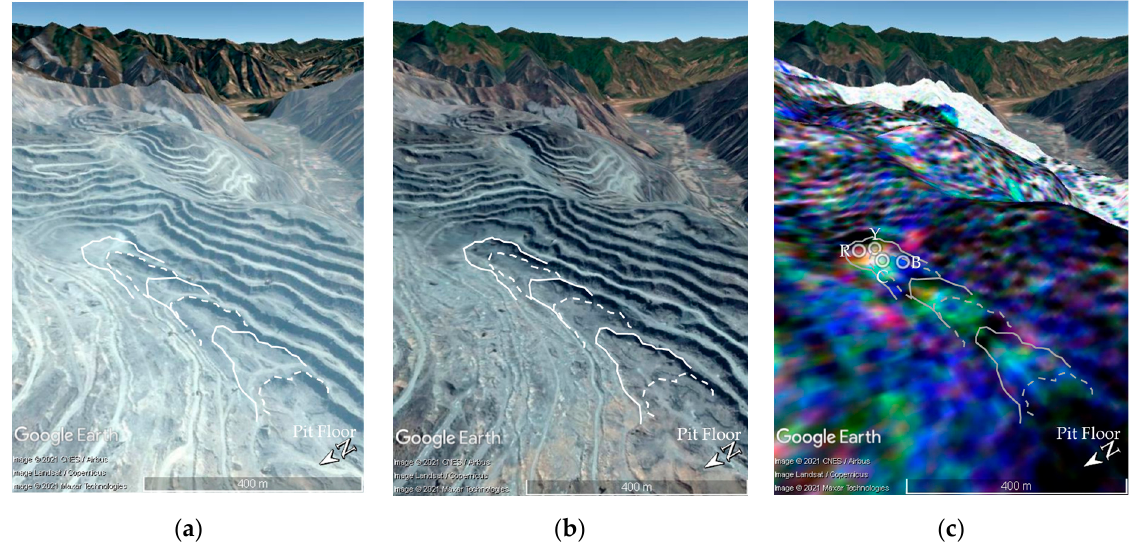
Figure 23. An excavation mining site. ( a , b ) are Google Earth images taken on 7 October 2015 and 26 September 2019, respectively. ( c ) is the RGB composite of the annually averaged NDAI map (R: 2019, G: 2018, and B: 2017) with several color points where 12-day NDAI graphs are shown in Figure 24. Dashed lines are drawn based on the 2015 Google Earth image, while solid lines are on 2019.